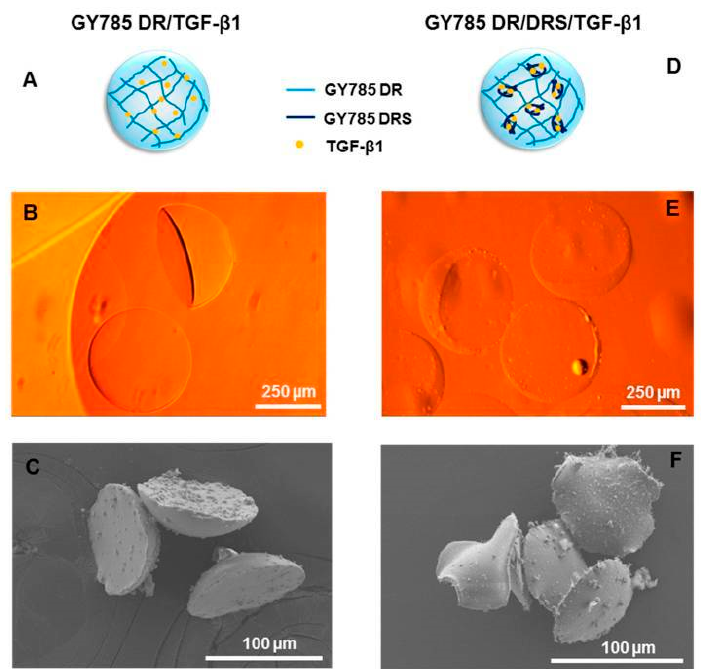
Figure 6. Single GY785 DR/TGF- β 1 microcarrier: ( A ) schematic representation of the microparticle section, ( B ) phase-contrast optical image, and ( C ) SEM image. Double GY785 DR/DRS/TGF- β 1 microcarrier: ( D ) schematic representation of the microparticle section, ( E ) phase-contrast optical image, and ( F ) SEM image. Figure and caption reused from Zykwinska et al. [187]. Used under the Creative Commons License (http://creativecommons.org/licenses/by/4.0/ (accessed on 28 January 2021)).